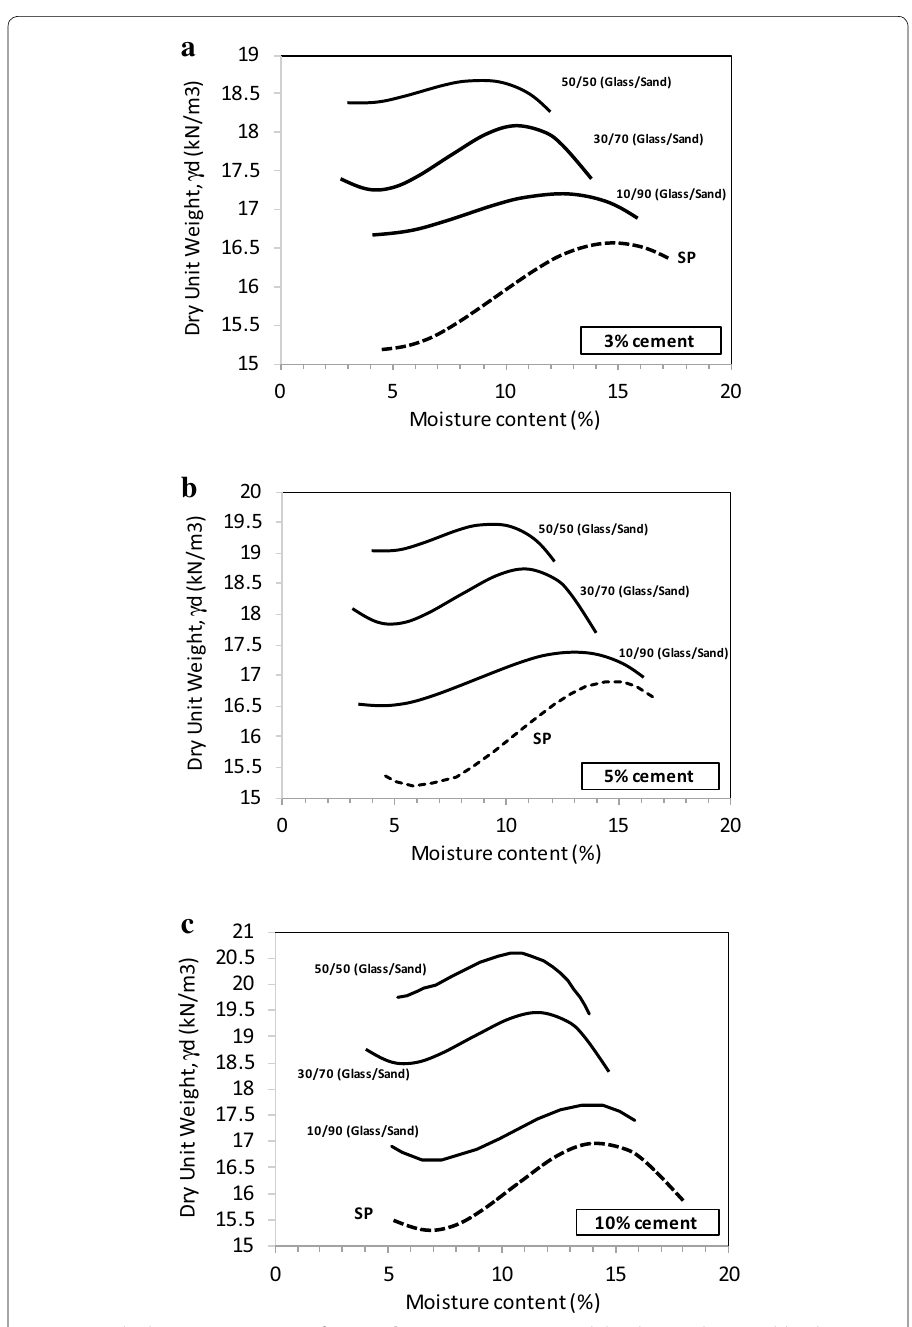
Fig. 2 Standard Proctor compaction for a 3%, b 5%, c 10% cements stabilized SM and CG–SM